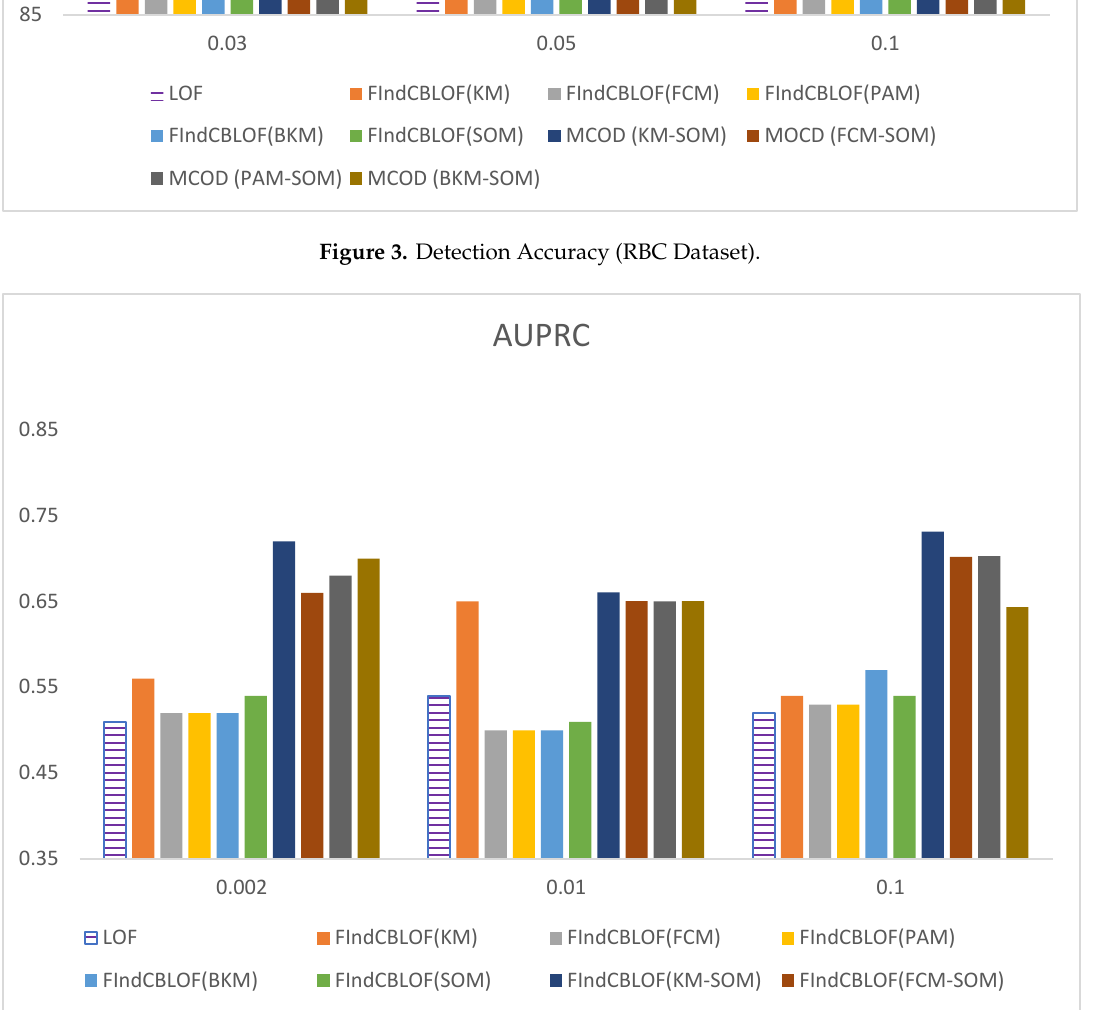
Figure 4. AUPRC (European Credit Dataset).